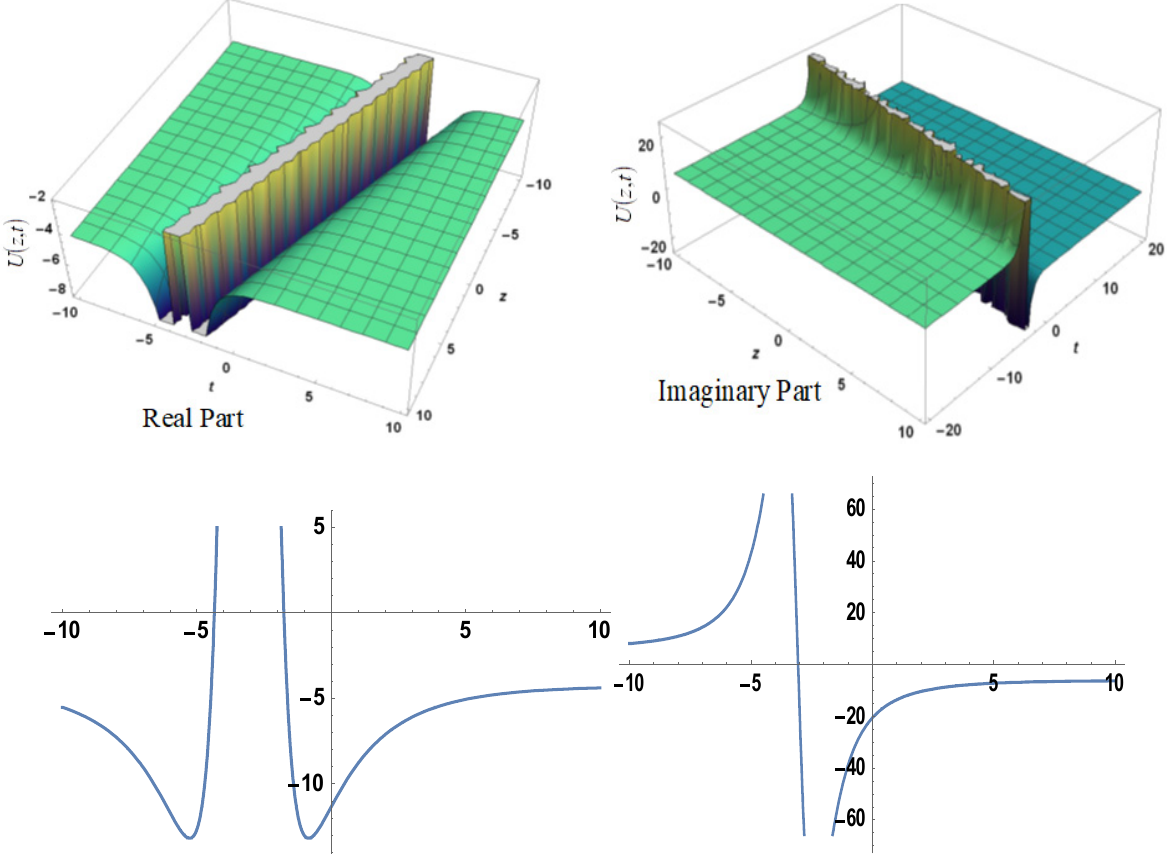
Figure 14. The 3D and 2D plots of Equation (64) for various values of parameters.